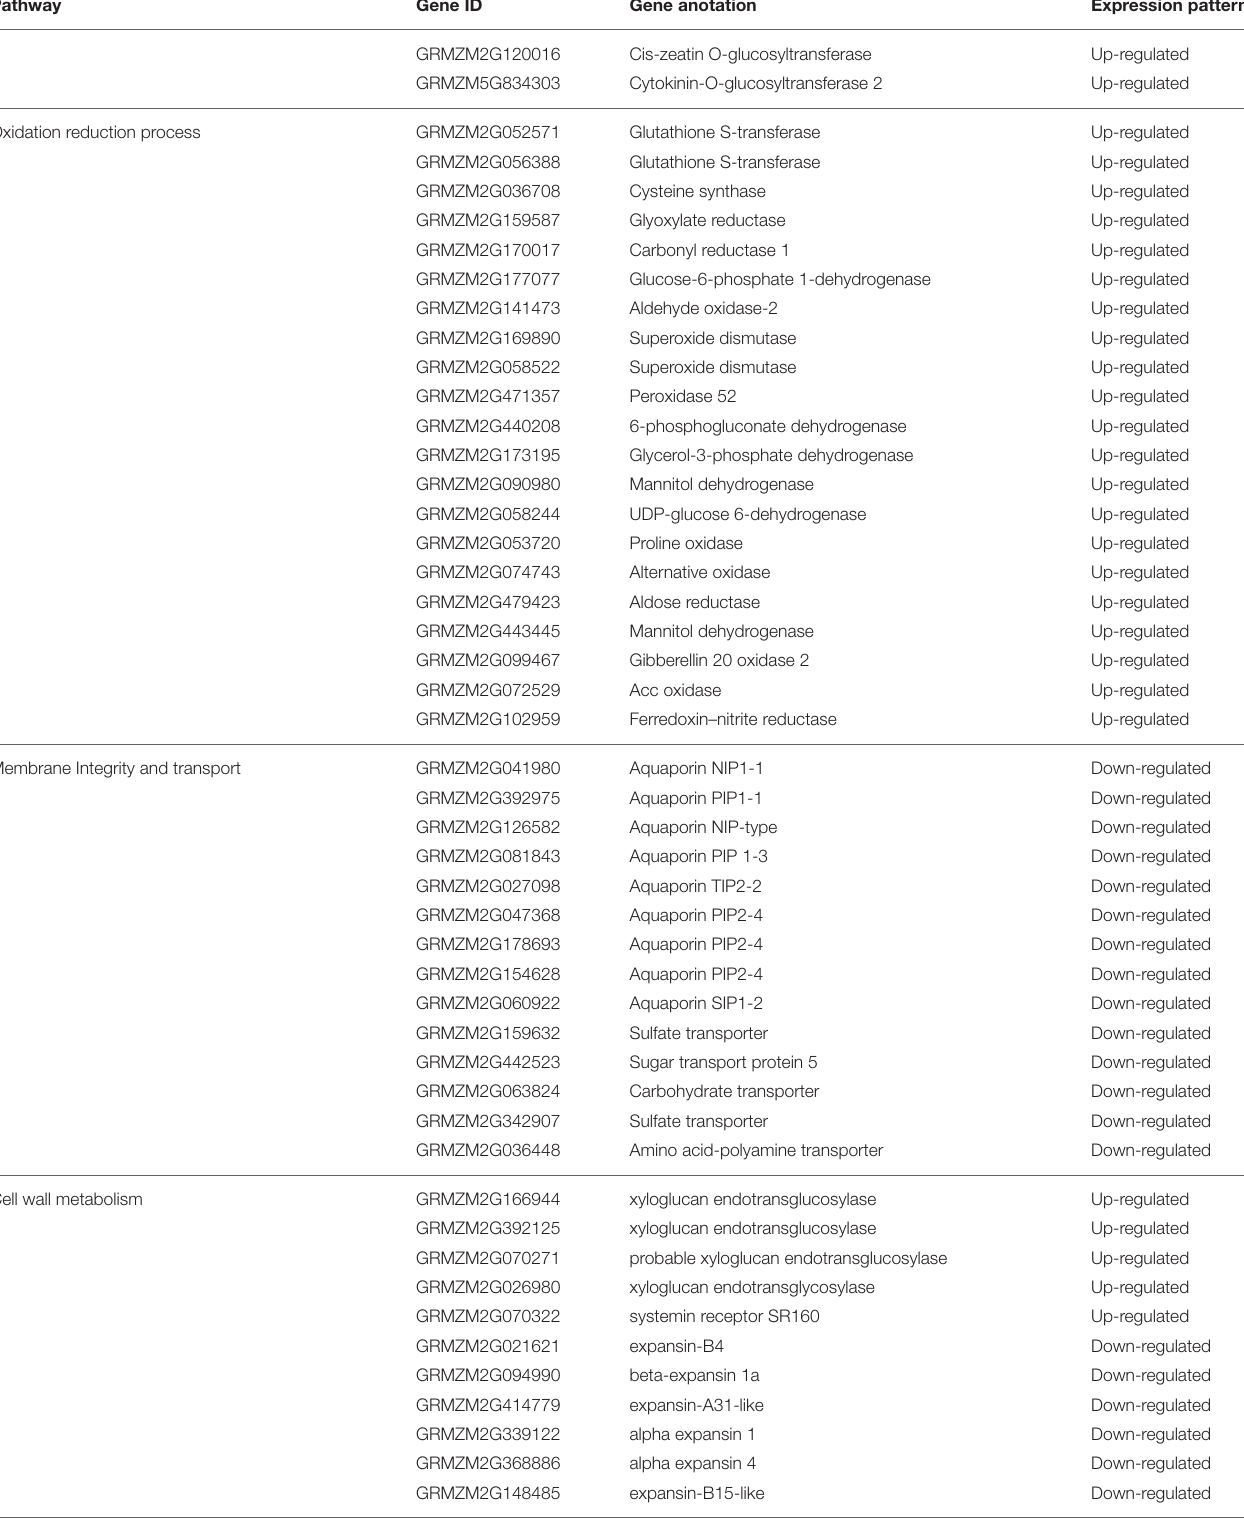
TABLE 3 | DEGs which involved in the cell wall metabolism.